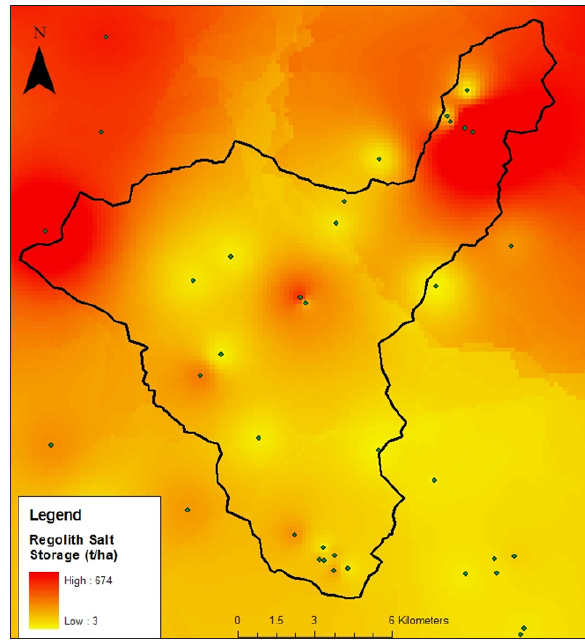
Interpolated regolith salt storage (t/ha) in the Sandspruit